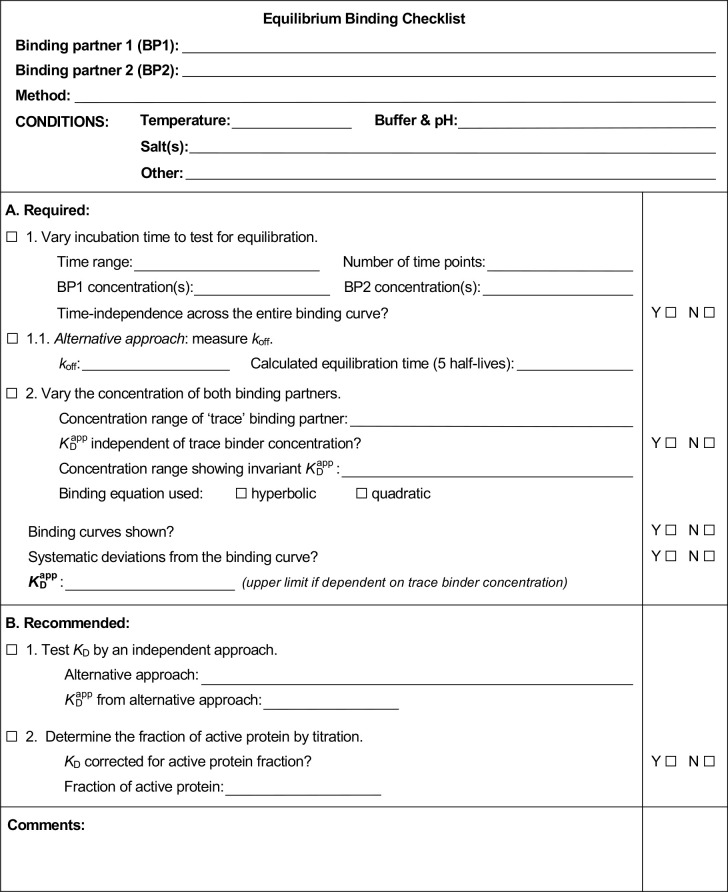
Equilibrium binding checklist template.